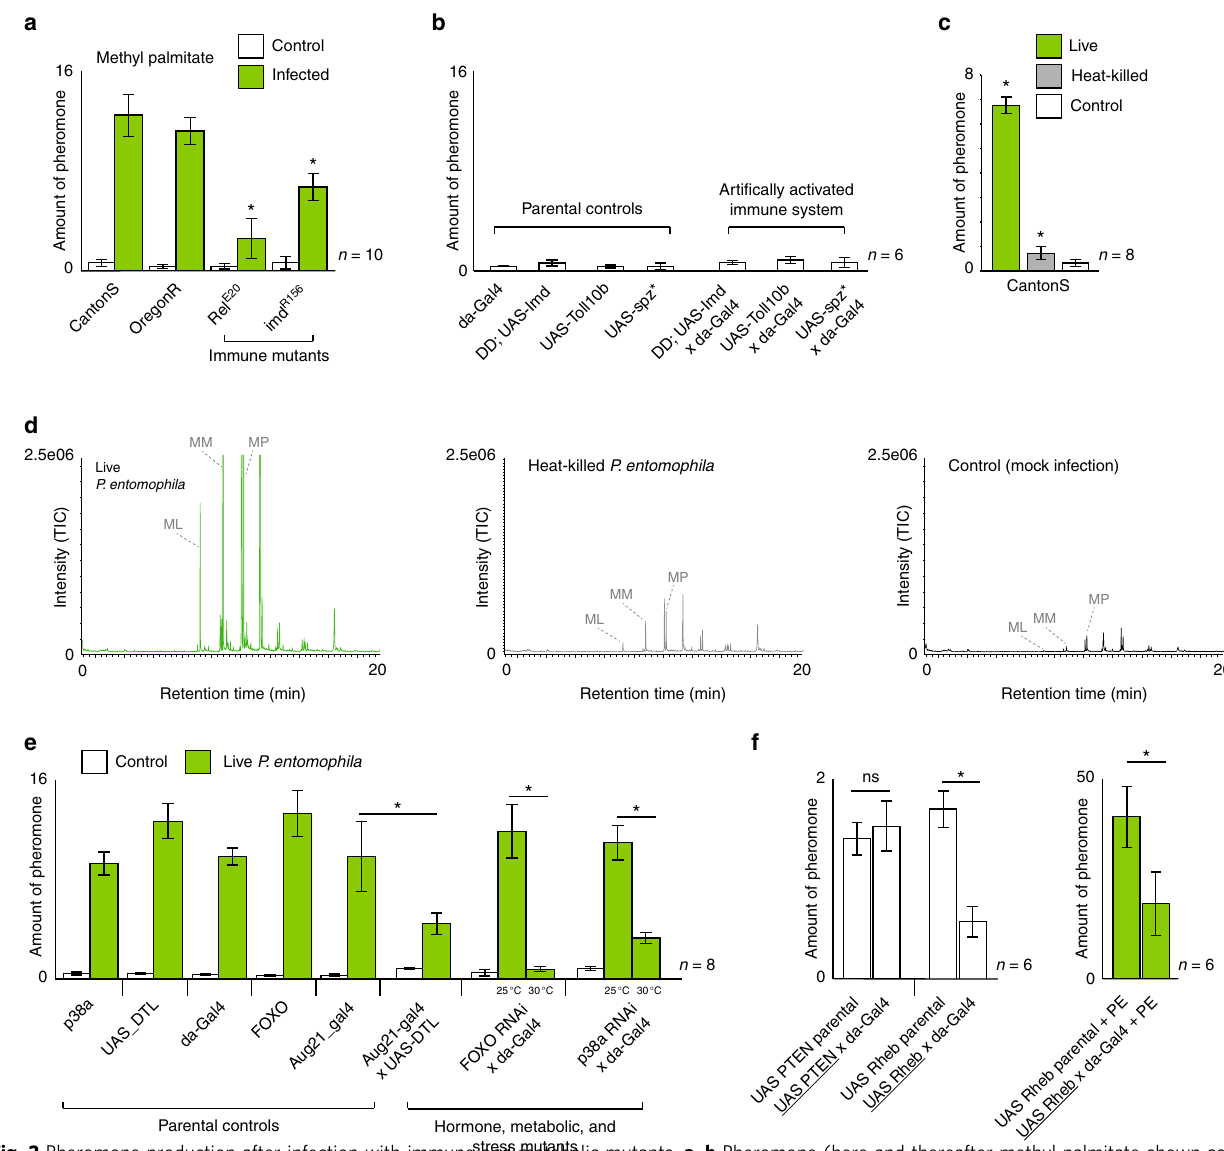
Fig. 2 Pheromone production after infection with immune and metabolic mutants. a , b Pheromone (here and thereafter methyl palmitate shown as example) production of CantonS or OregonR wild-type fl ies, and fl ies de fi cient in the Imd immune response pathway (RelE20 and IMD 156 ) with Pseudomonas entomophila infection ( green ) and without ( white ; a ), or of fl ies, where the IMD (Imd fl ies) or the Toll (Toll fl ies and spz* fl ies) response pathway were arti fi cially activated ( b ). c Pheromone production after infection with live ( green ) or heat-killed ( gray ) bacteria. d GC-MS pro fi les of live bacteria, heat-killed bacteria, and mock-infected control fl ies. e Pheromone production of fl ies with either decreased juvenile hormone (Aug21-gal4 x UAS-DTI fl ies), insulin metabolism (FOXO fl ies), or stress responses (p38a fl ies) and their parental control lines. RNAi lines tested at the non-active 25 °C served as further controls. f Pheromone production of fl ies with or without arti fi cial activation of Rheb (an inhibitor of the FOXO pathway) with infection ( green ) or without ( white